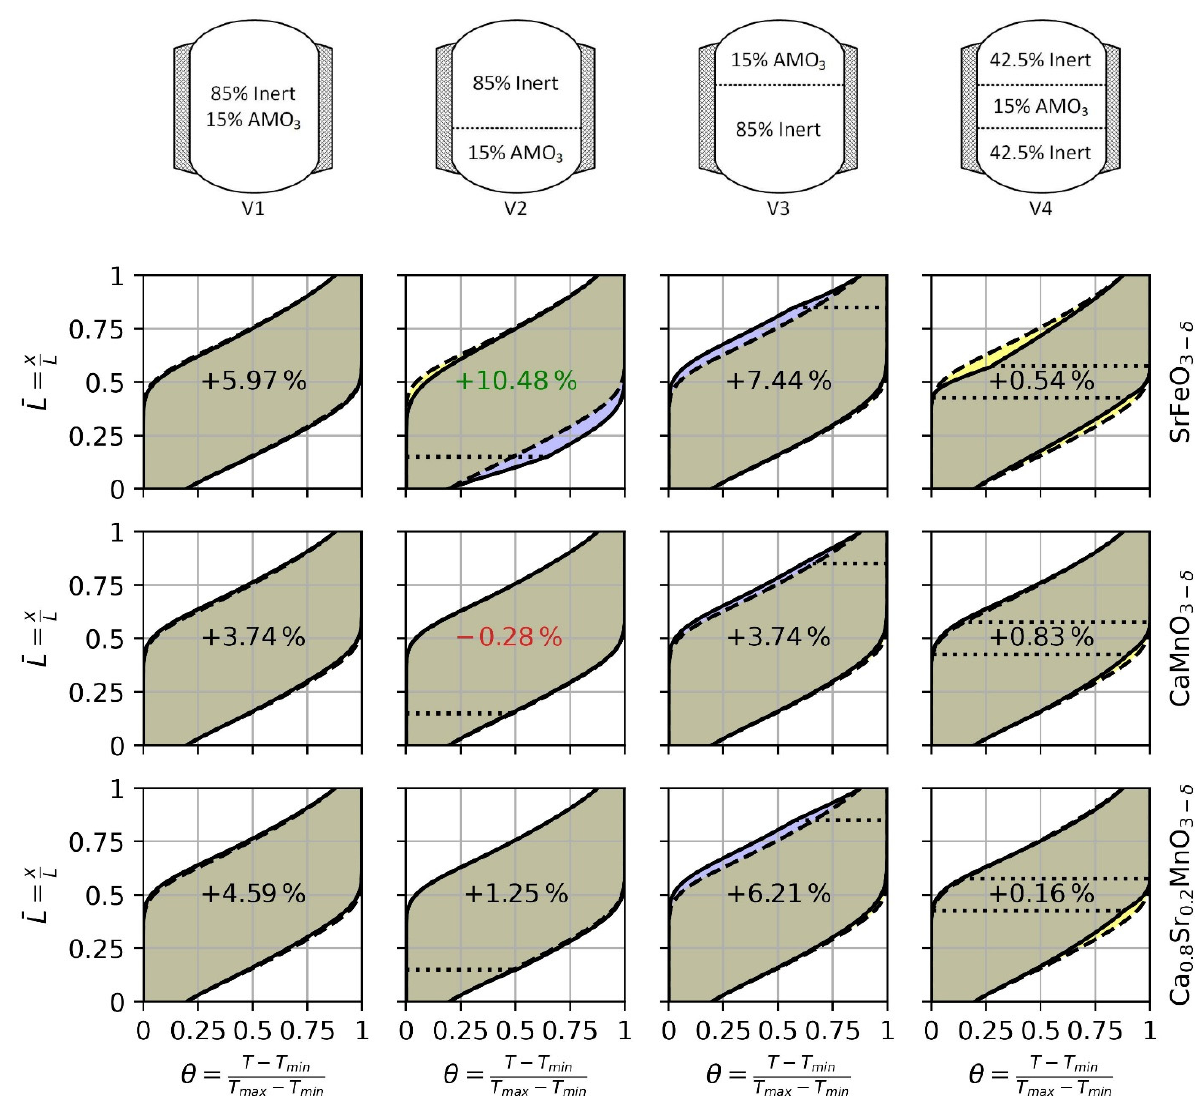
Figure 7. Thermoclines behavior after 15 cycles of the four investigated storage concepts with SrFeO 3 − δ , CaMnO 3 − δ and Ca 0.8 Sr 0.2 MnO 3 − δ . The dashed line shows the thermocline at end of charge and discharge of the base case (V0) and the solid line shows the thermocline of V1, V2, V3, and V4 for the selected perovskite. The purple and yellow area indicate an increase and decrease of the local material utilization, respectively.The dotted lines indicate the placement of the reactive material in V2, V3 and V4. The values in the center of each figure show the change in storage capacity compared to the base case